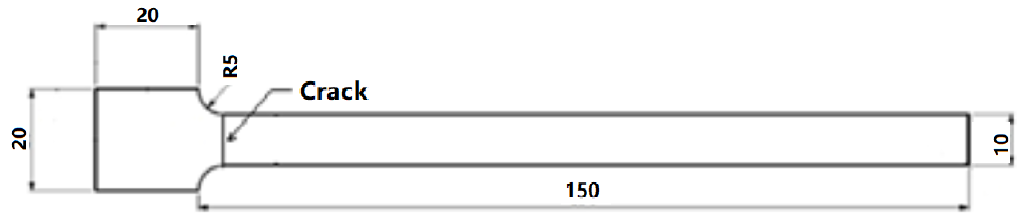
Figure 2. Specimen geometry and dimensions.